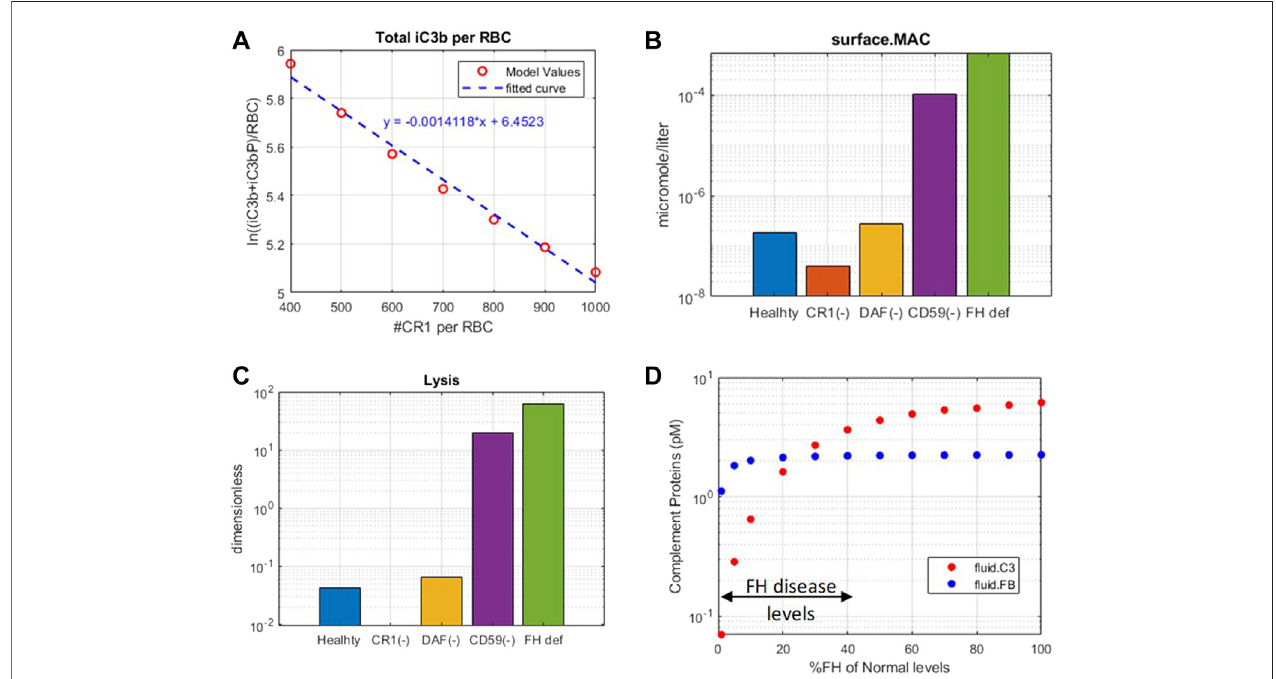
FIGURE 8 | Complement model predictions for (A) correlation between iC3b + iC3bP deposition on erythrocytes and levels of CR1, (B) surface MAC, (C) lysis of host erythrocytes due to 99% reduction in CR1, DAF, and CD59 and 50% reduction in fl uid-phase regulator FH, and (D) consumption of complement proteins C3 and FB due to FH de fi ciency ranging from 0 to